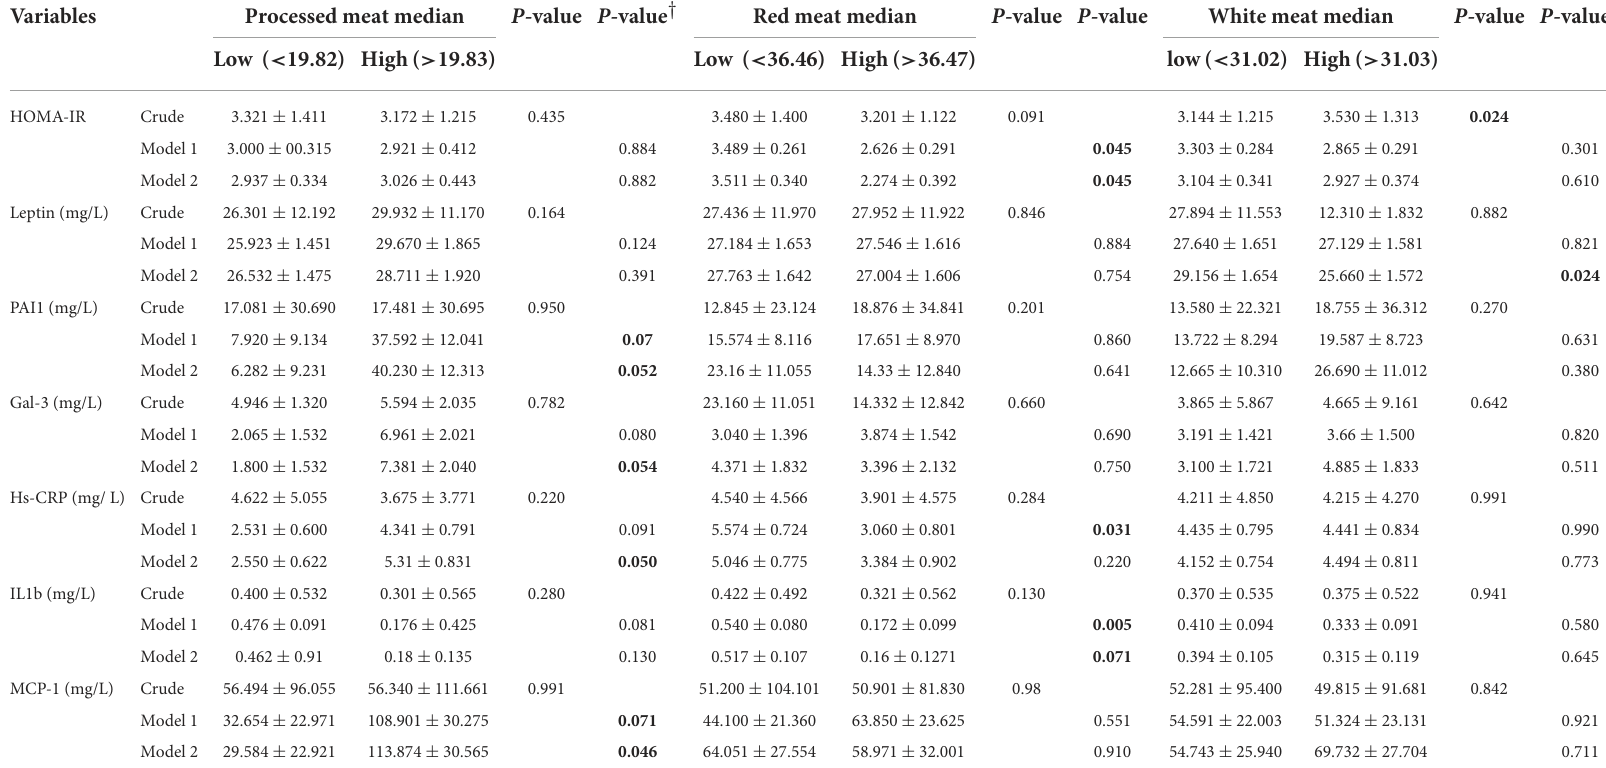
TABLE 3 Inflammatory biomarkers between low and high category of processed meat, red meat and white meat (g/d) in 391 obese and overweight women.